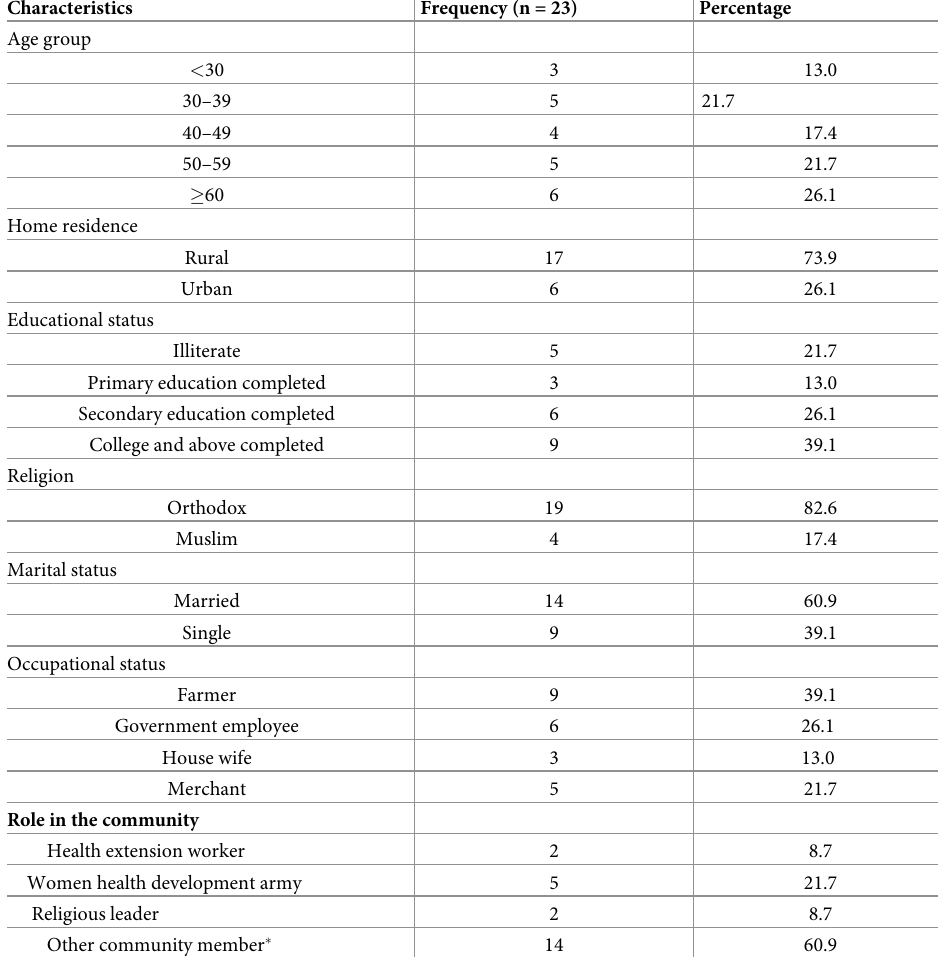
Table 1. Socio-demographic characteristics of study participants for in-depth interview and focus group discus- sion in South Gondar Zone, Northwest Ethiopia, 2020.